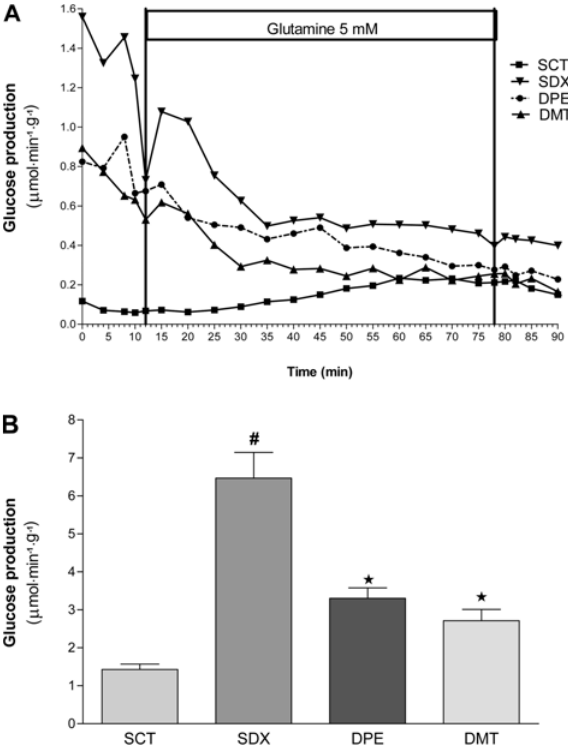
Figure 3. Hepatic production of glucose in different animal groups. SCT: Sedentary control group (n=8) treated with 0.9% NaCl solution ( sc , for 4 days) without swimming activity. SDX: Sedentary dexamethasone group (n=12) treated with 0.1 mg/kg dexamethasone (DEXA, sc, daily, for 4 days), without swimming activity. DPE: DEXA-treated physical exercise group (n=10) treated with 0.1 mg/kg DEXA ( sc, daily, for 4 days), with swimming activity (4 days, 1 h/day). DMT: DEXA and metformin (MET) treated group (n=12) treated with MET (300 mg (cid:1) kg – 1 (cid:1) day – 1 ; gavage, for 4 days), without swimming activity. A , Data are reported as means ± SE. B , Data are reported as the mean area under the curve ± SE. # P o 0.01 compared with the SCT group. *P o 0.01 compared with the SDX group (ANOVA followed by Tukey ’ s